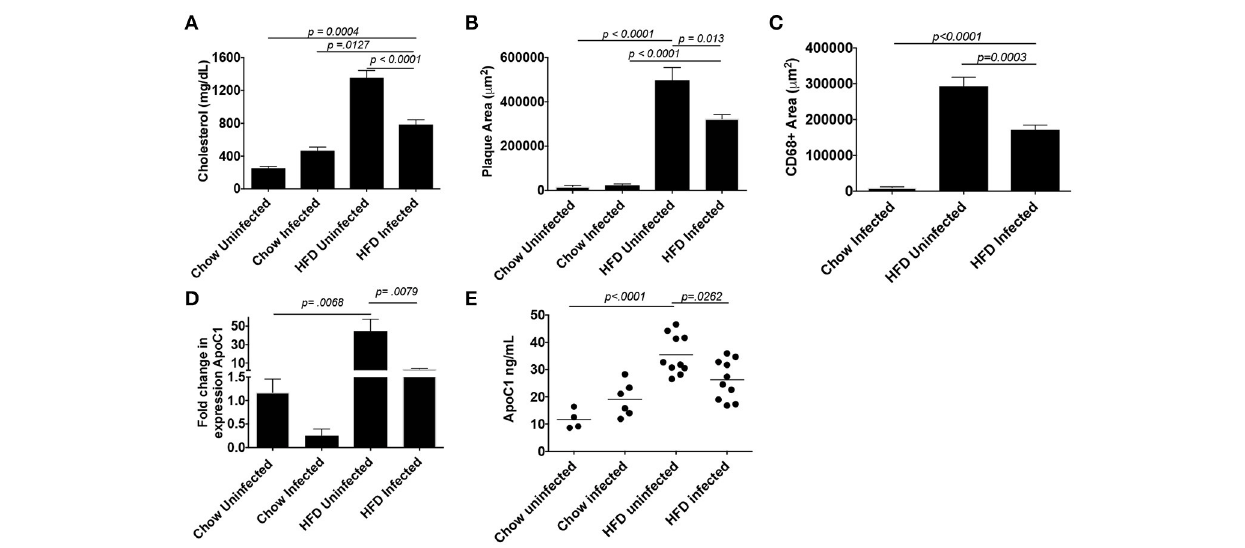
FIGURE 5 | S. mansoni infection reduces hyperlipidemia, plaque, and macrophage area and well as systemic ApoC1 production in HFD fed ApoE − / − mice. ApoE − / − male mice were fed HFD or standard chow diet for 10 days before infection with S. mansoni . At 10-weeks post infection, mice were sacrificed. (A) Fasting plasma cholesterol measurements. (B-C) Quantitation of plaque and macrophage area (CD68 + ) from the aortic sinus. (D) QPCR analysis of ApoC1 in whole liver RNA, data are normalized to Chow infected animals. (E) Quantitation of ApoC1 in plasma at the time of sacrifice. All data shown are two combined experiments with 4–8 mice per group in each experiment. The experiment was performed 4 times. Statistical significance was calculated using ANOVA and